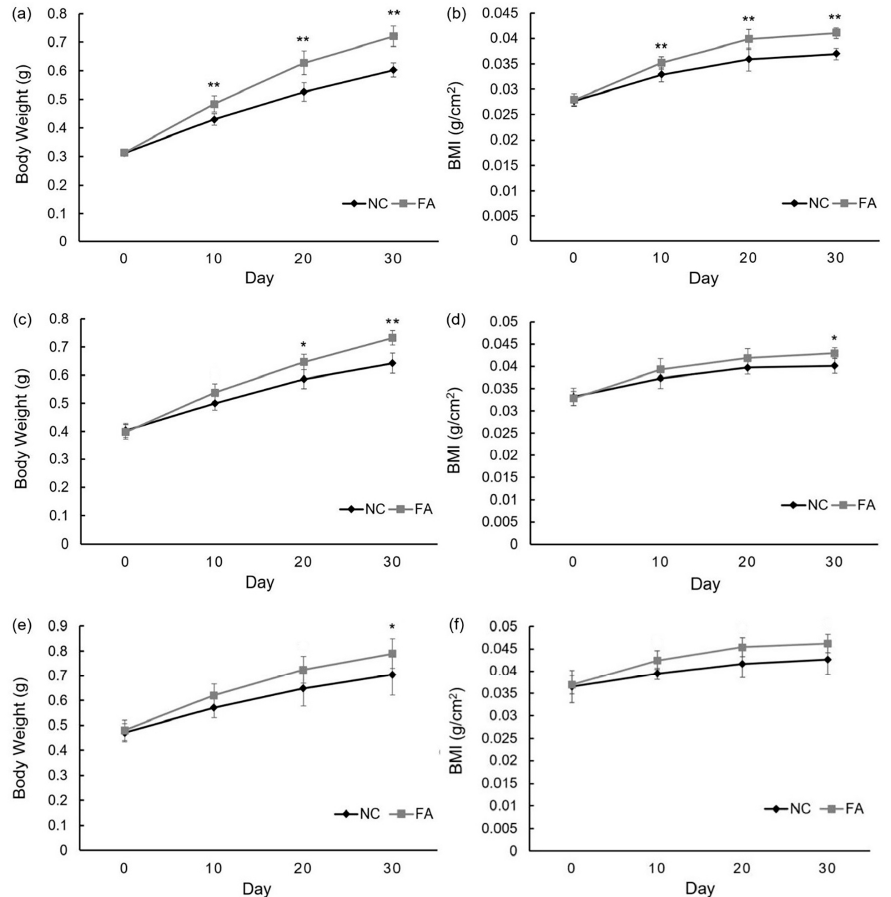
Figure 1. Effects of ferulic acid on body weight and body mass index of adult zebrafish. Population 1: ( a ) average body weight of each group; ( b ) average BMI of each group throughout feeding experiment; Population 2: ( c ) average body weight of each group; ( d ) average BMI of each group throughout feeding experiment; Population 3: ( e ) average body weight of each group; ( f ) average BMI of each group throughout the feeding experiment; NC: negative control group; and, FA: ferulic acid administered group. Data are expressed as mean ± SD ( n = 10, for each group from Population 1; n = 5, per group from Population 2 and 3), * p < 0.05, ** p < 0.01 compared with the NC group.